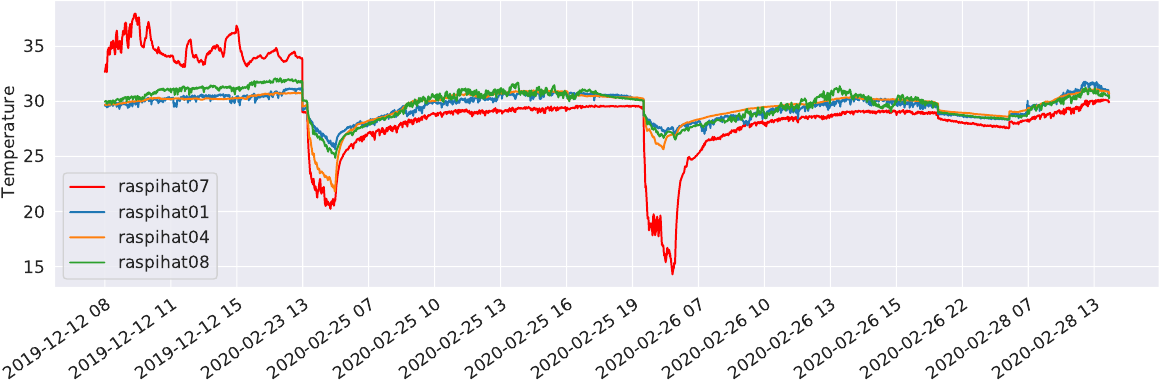
Figure 18. Sensor raspihat07 temperature values related to the prediction error outliers compared with the three nearest- neighbour